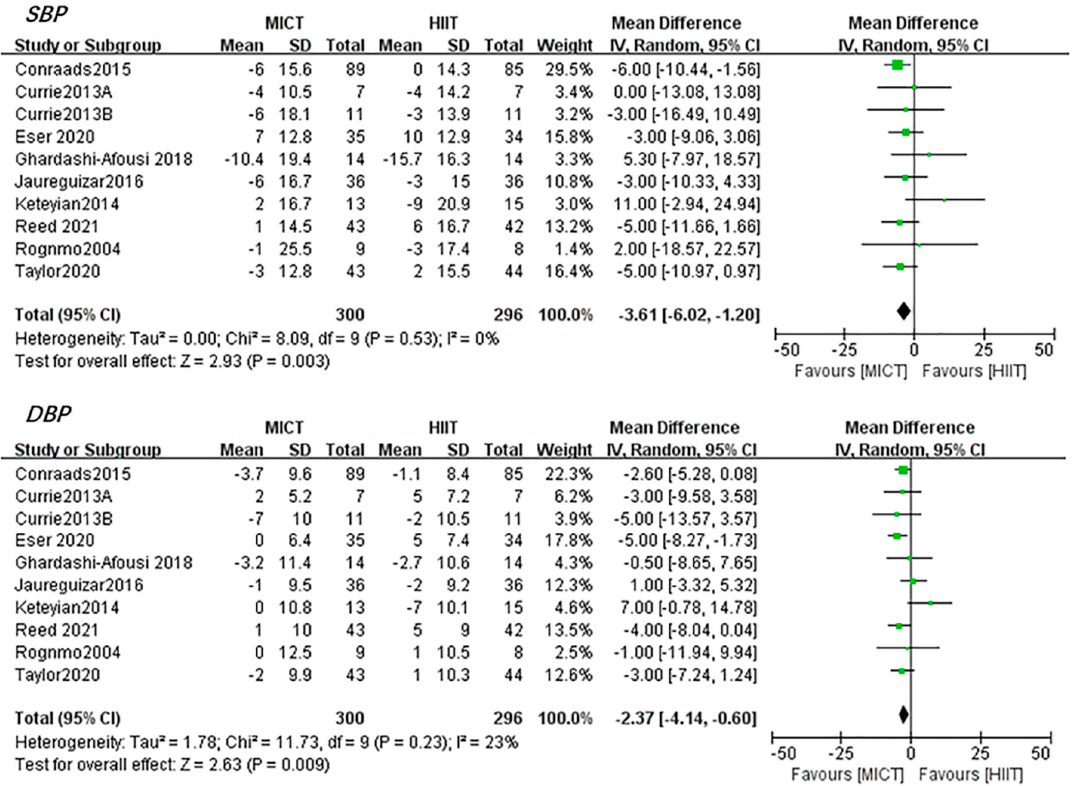
Figure 6. Changes in resting BP between HIIT and MICT. The green and black symbol means the mean difference of each study and total mean difference.